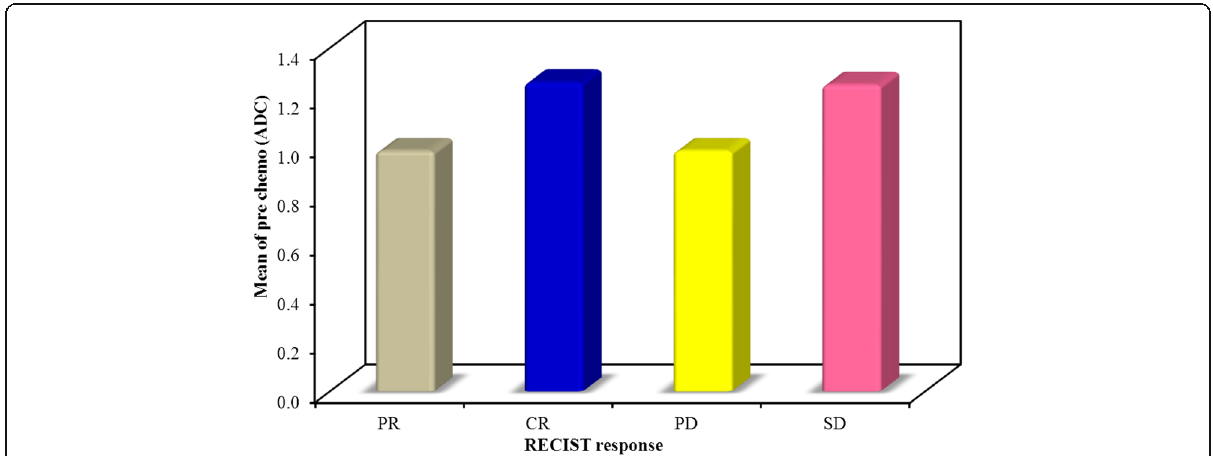
Fig. 1 Pre-treatment ADC values in different